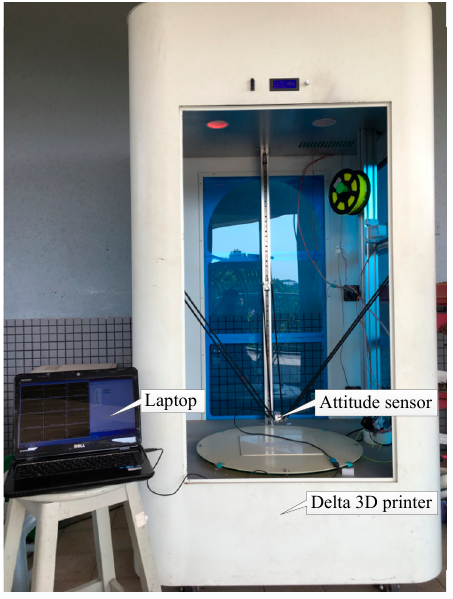
Figure 6. Experimental configurations for the fault diagnosis of the delta 3D printer.